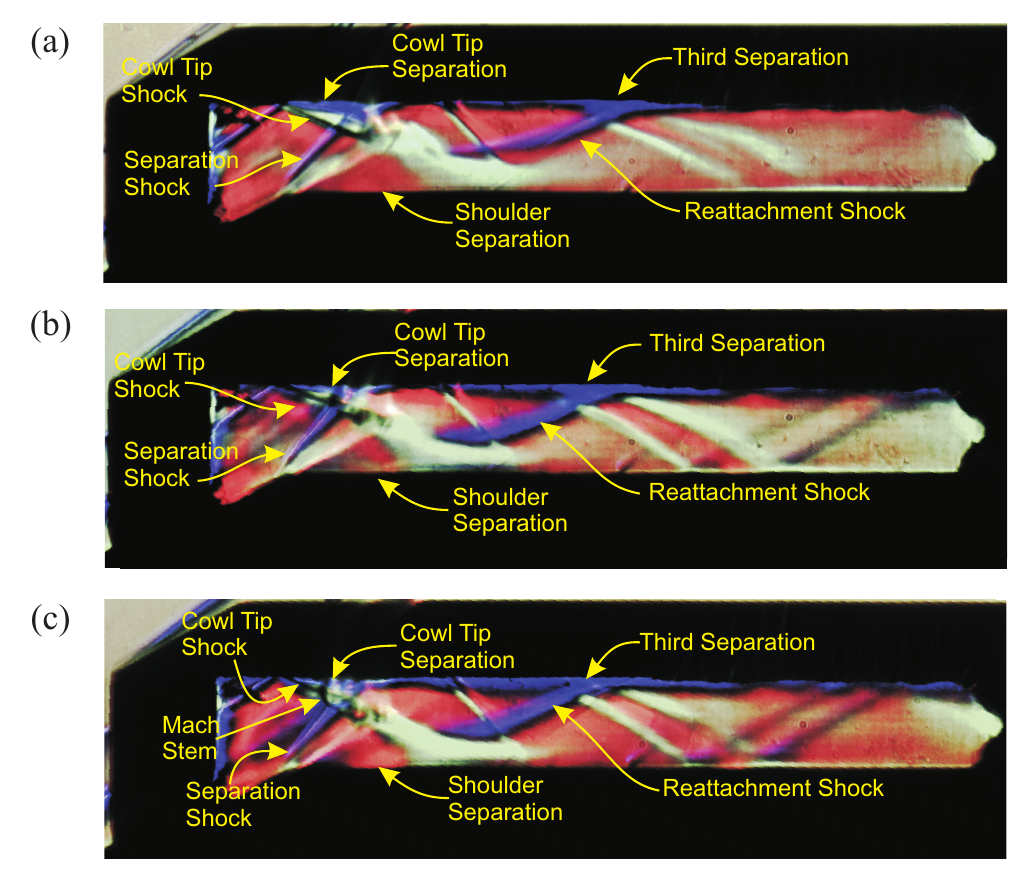
Figure 12. Comparison of schlieren images for different cases: ( a ) baseline; ( b ) AoA-2; ( c )